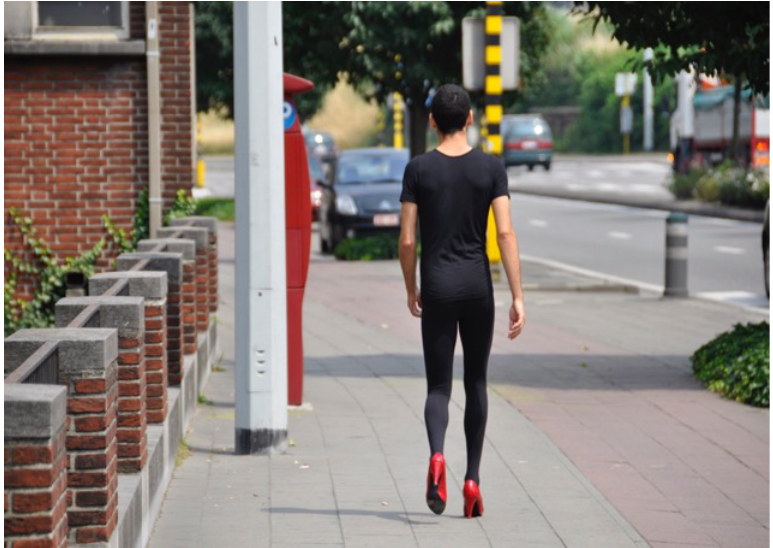
Mehdi-Georges Lahlou, Walking 30km with red high heel shoes between 2 art spaces (detail), 2009. From Galerie Transit, Mechelen to Lokaal 01, Antwerp, Belgium. 9-hour performance. Image courtesy of the artist and Galerie Transit, Mechelen, Belgium. (photo: Bert de